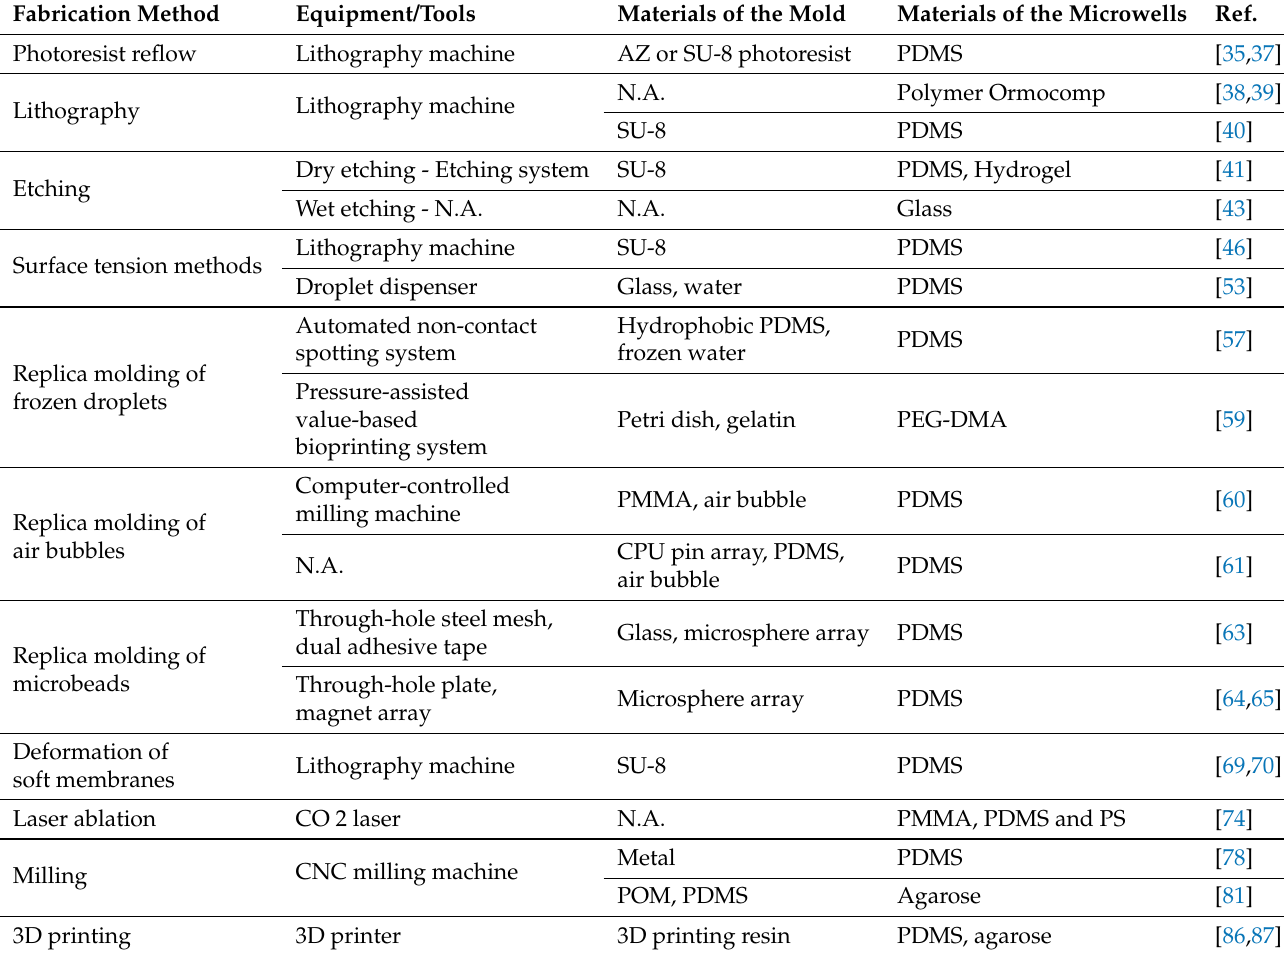
Table 1. Summary of fabrication methods for concave